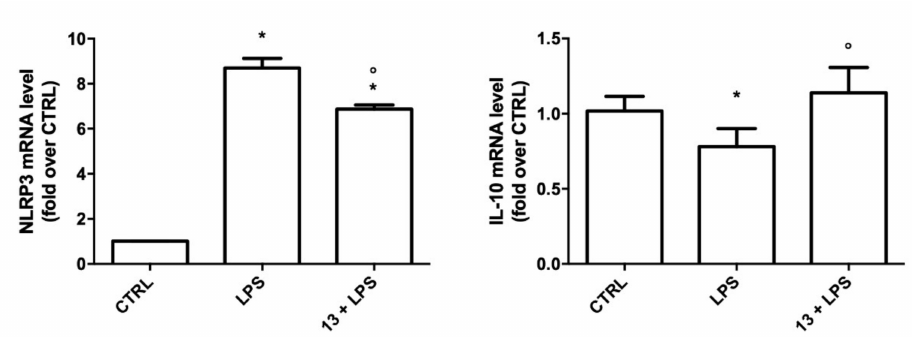
Figure 6. Expression of NLRP3 and IL-10 in BV-2 cells treated with 13 . Cells were treated with 10 nM 13 , exposed to 100ng/mL LPS for 24h and NLRP3 and IL-10 mRNA levels were measured by RT-PCR. Data are expressed as relative abundance compared to untreated cells. Each bar represents the mean ± SEM of three independent experiments. Data were analyzed with one-way ANOVA followed by Bonferroni’s test. * p < 0.05 vs. CTRL; ◦ p < 0.05 vs.